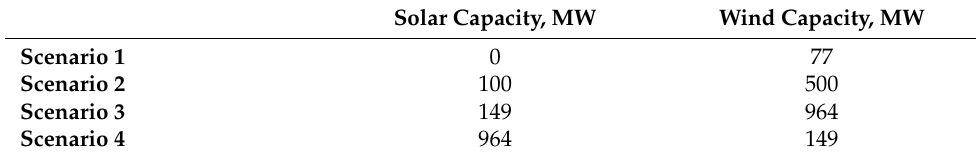
Table 2. Installed capacities of variable renewable energy (VRE) sources in different